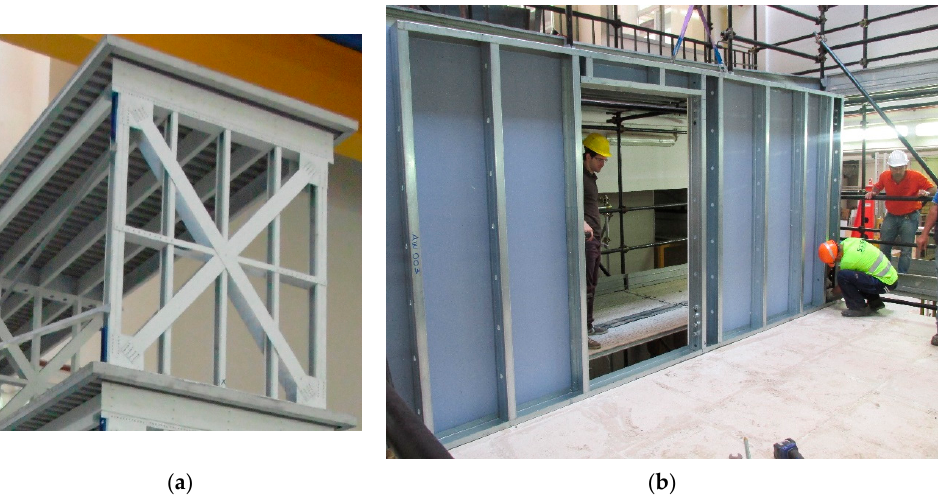
Figure 1. Cold-formed steel (CFS) structural systems: walls. ( a ) X-braced wall; ( b ) sheathed-braced wall.